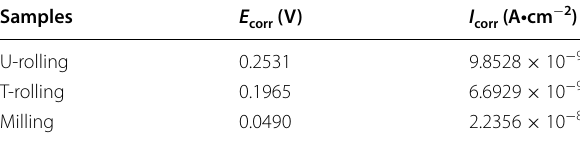
Table 6 Self-corrosion potential and self-corrosion current density of